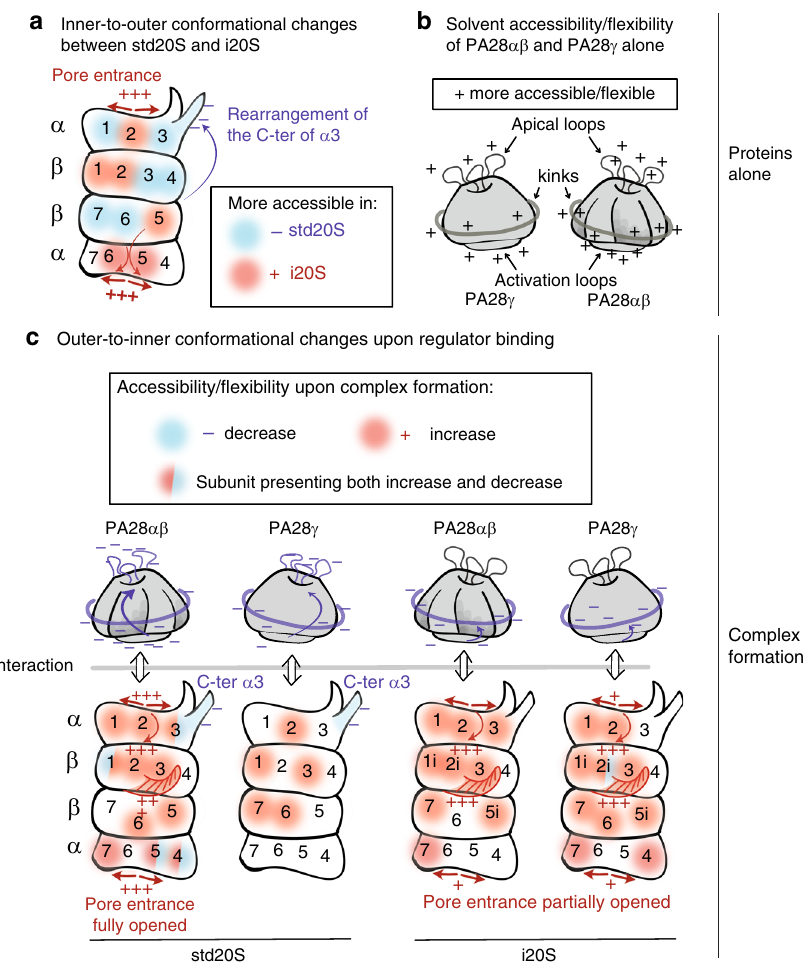
Fig. 8 Schematic representation of our major fi nding. a Comparison of std20S vs. i20S deuteration pro fi les con fi rms an inner-to-outer allosteric change: the differences between the std20S- and i20S-speci fi c subunits β 1/1i, β 2/2i and β 5/5i located inside the complex trigger conformational changes at the pore entrance (aperture in the i20S: +++ ) and external surface of the proteasome, including the C-ter of α 3 (inner-to-outer change represented as an arrow). The subunits that are more accessible/ fl exible in the std20S and the i20S are presented in blue and red, respectively. b PA28 solvent accessibilities analysed alone indicate similarities in their dynamic regions: their apical loops, kinks and activation loops were more deuterated (indicated with + ). c 20S- and PA28-speci fi c reorganizations occurring upon complex formation. This schematics presents the results of the comparison of HDX-MS data from the PA28 and std/i20S alone vs. in complex. The subunits in red and blue were globally more and less deuterated in the complex than in the protein alone, respectively. More localised changes are indicated by half-circles. Opening of the 20S pore entrance is indicated with + and +++ (for minor and more pronounced increase of deuteration) as well as the reorganisation of the C-ter of β 2 and β 2i upon complex formation. − indicates the area of the proteins that were protected upon binding (apical loops, kinks and activation loops of the regulators; C-ter of α 3 in the